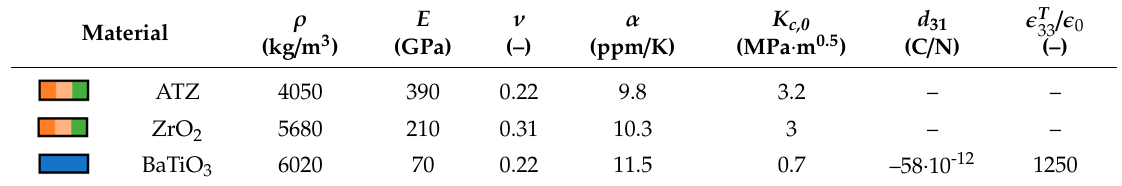
Table 1. Mechanical and piezoelectric properties of used materials [24,28,29].